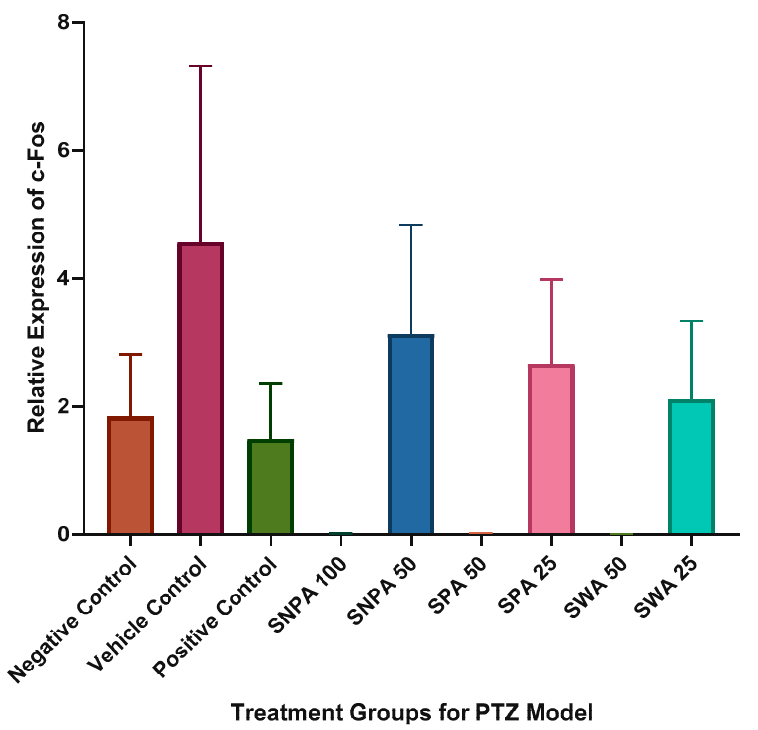
Figure 7. Graphical representation of the relative expression of c-Fos in treatment groups ( n = 6). The data were expressed as mean ± SEM using one-way ANOVA.